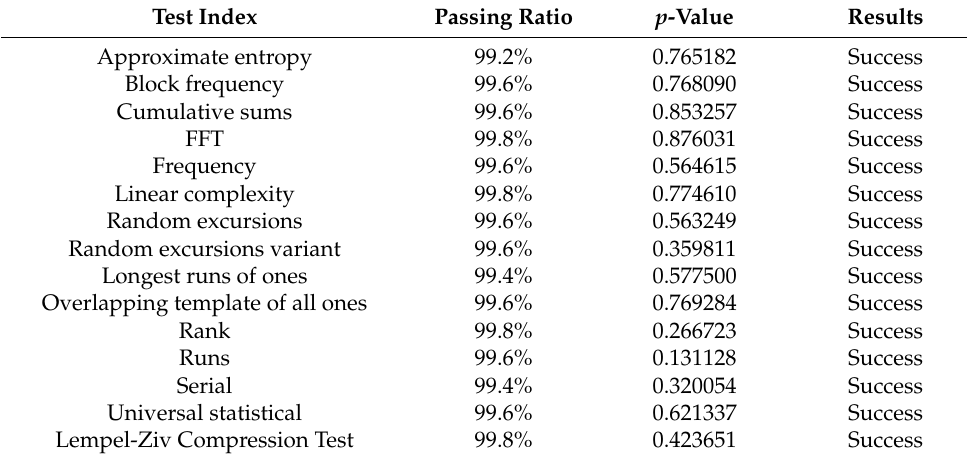
Table 1. NIST test results of the LB compound chaotic map. Test Index Passing Ratio p